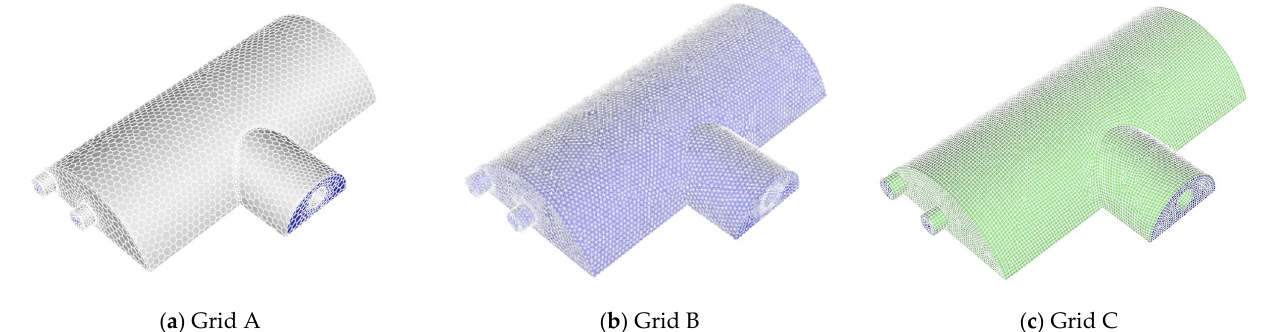
Figure 5. The meshing of the three grids.